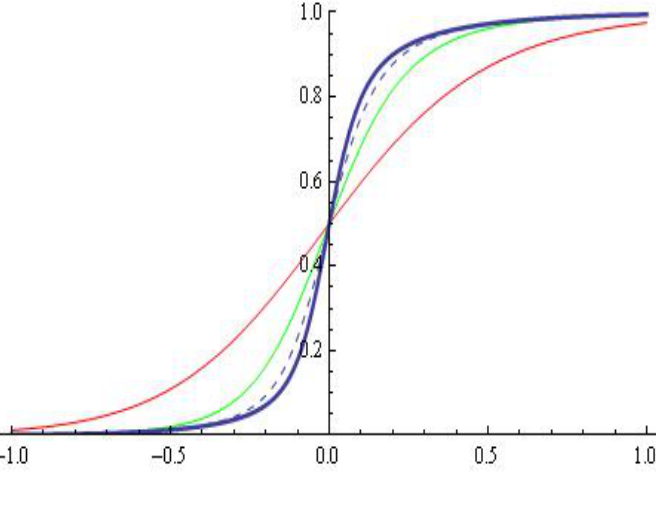
The recurrence generated sigmoidal hyper–log–logistic functions: N 0 ( t ) (red); d 0 = 0 . 21821 , N 1 ( t ) (green); d 1 = 0 . 134208 , N 2 ( t ) (dashed); d 2 = 0 . 095564 and N 3 ( t ) (thick); d 3 = 0 . 0749788